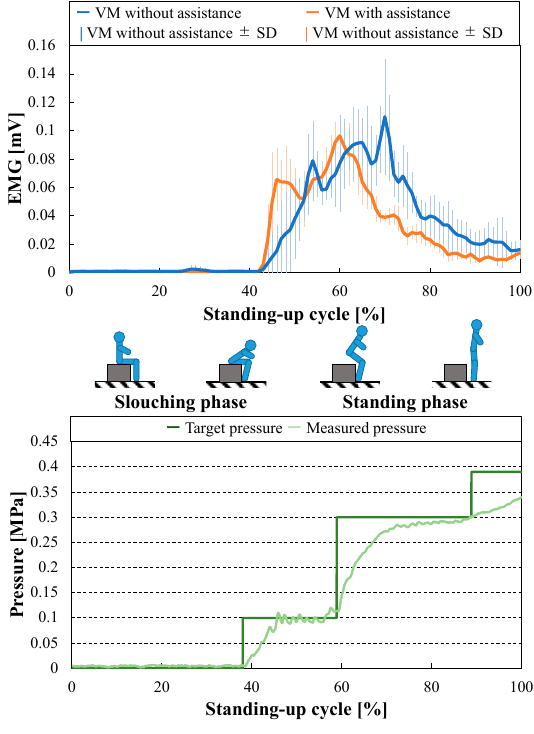
Table 5. Subject information in the assist evaluation of the gait motion.